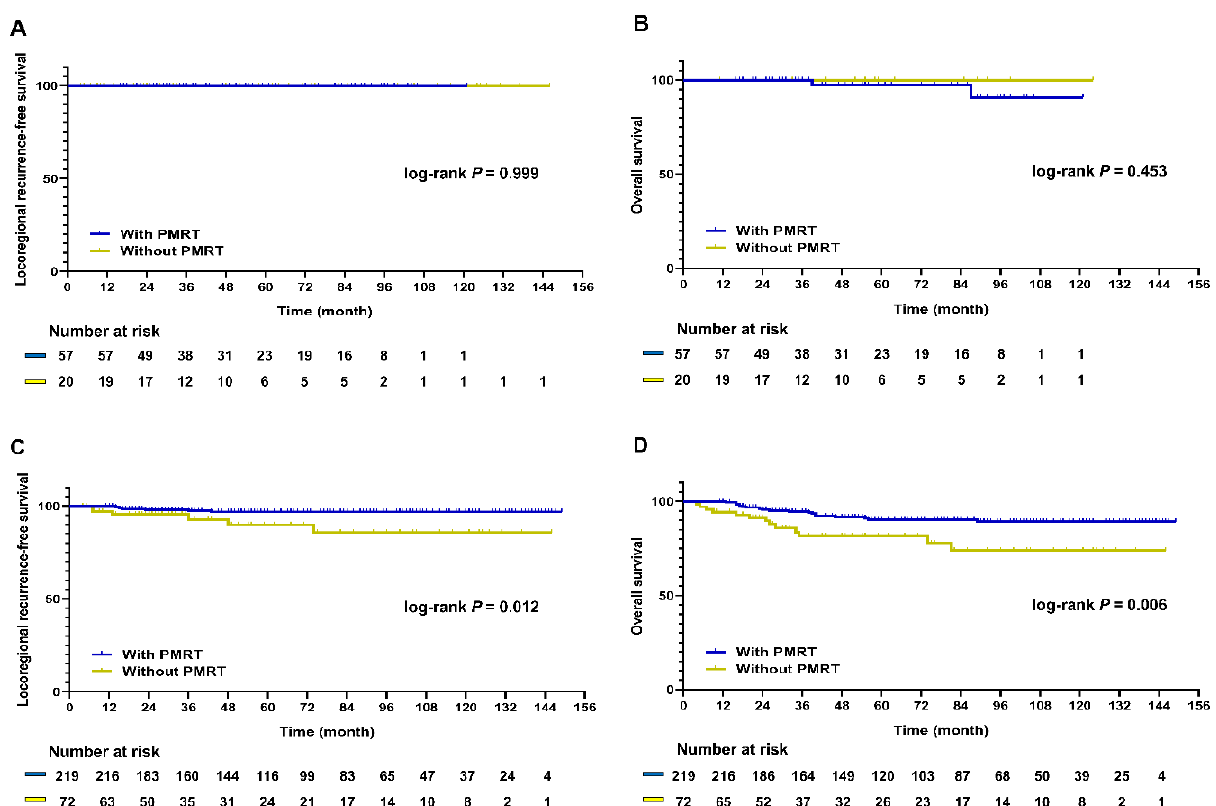
Figure 2. Kaplan–Meier survival curve of LRRFS and OS according to PMRT and pCR status after 1:3 PSM. ( A ) LRRFS in the pCR group ( p = 0.999); ( B ) OS in the pCR group ( p = 0.453); ( C ) LRRFS in the non-pCR group ( p = 0.012); ( D ) OS in the non-pCR group ( p = 0.006). LRRFS, locoregional recurrence-free survival; OS, overall survival; PMRT, post-mastectomy radiotherapy; pCR, pathologic complete response; PSM, propensity score matching.